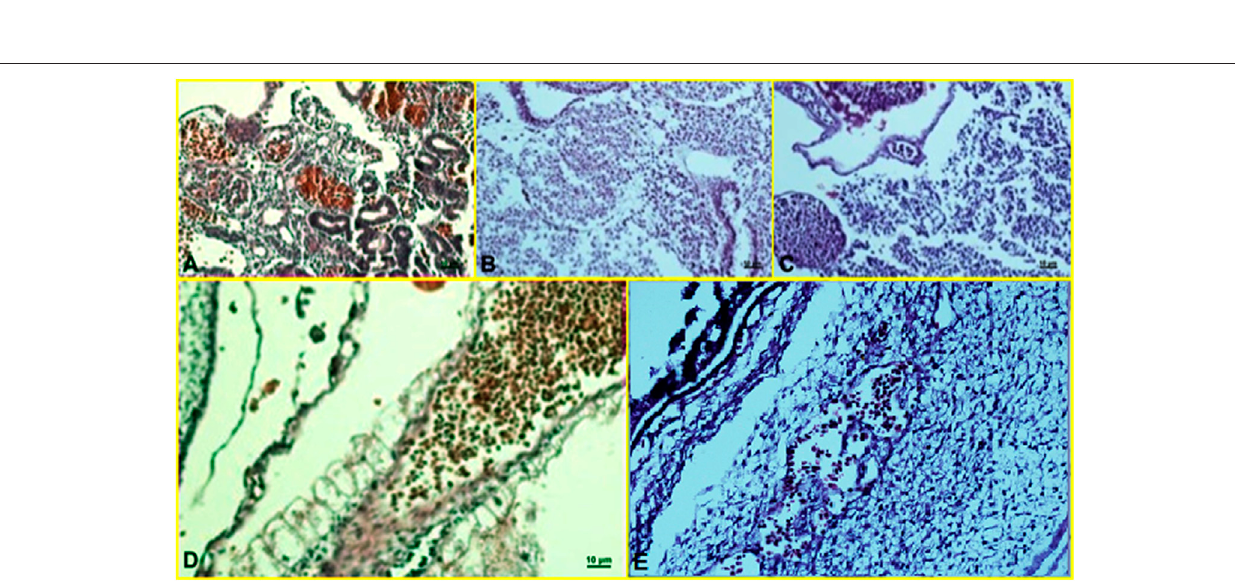
Frontiers in Pharmacology |